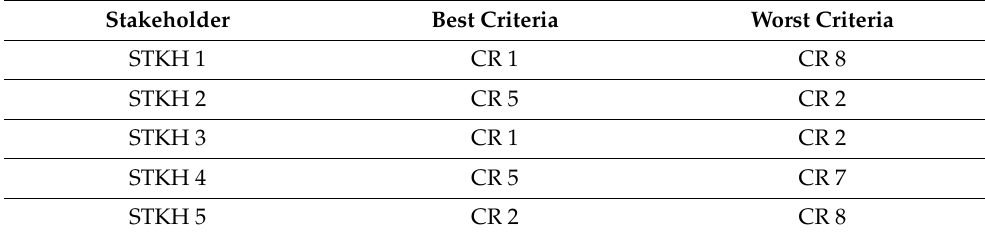
Table 3. Best and worst criteria by stakeholder.